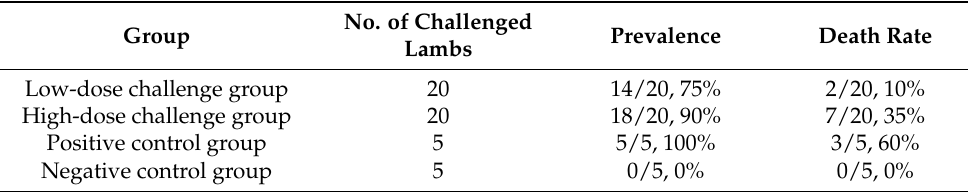
Table 3. Pathogenicity Record of E. coli F17 challenge experiment.